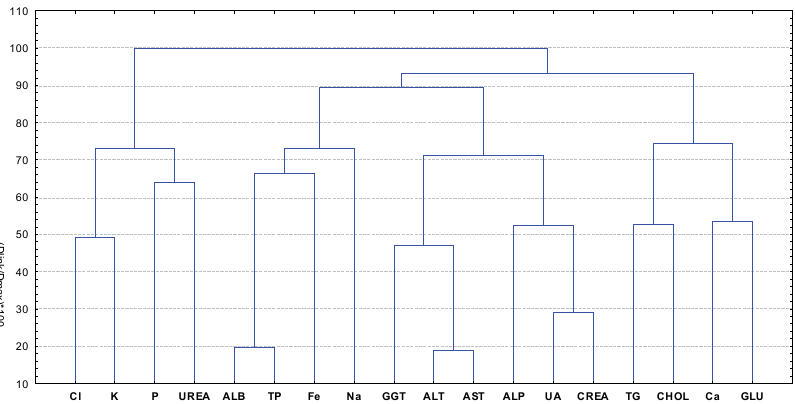
links between the biochemical parameters being studied. In Figure 1 , the hierarchical dendrogram for the clustering of the biochemical parameters for all investigated healthy subjects (N = 166) is plotted (complete method of linkage, squared Euclidean distance as similarity measure, standardization of the input data). For clustering, a total of 18 clinical parameters were chosen (Table 1 ).